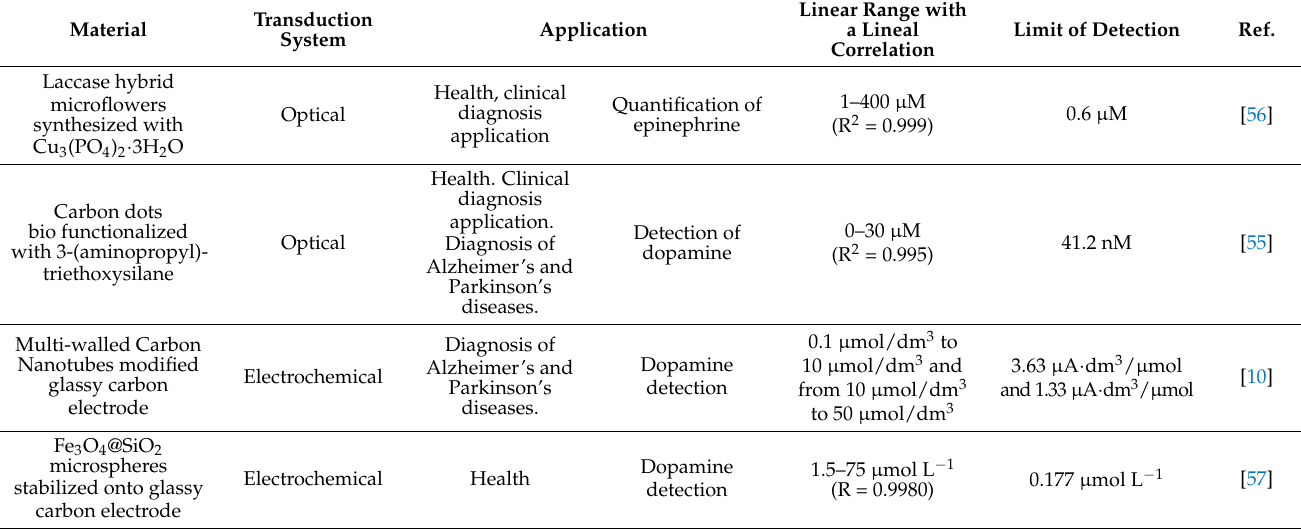
Table 3. Laccase